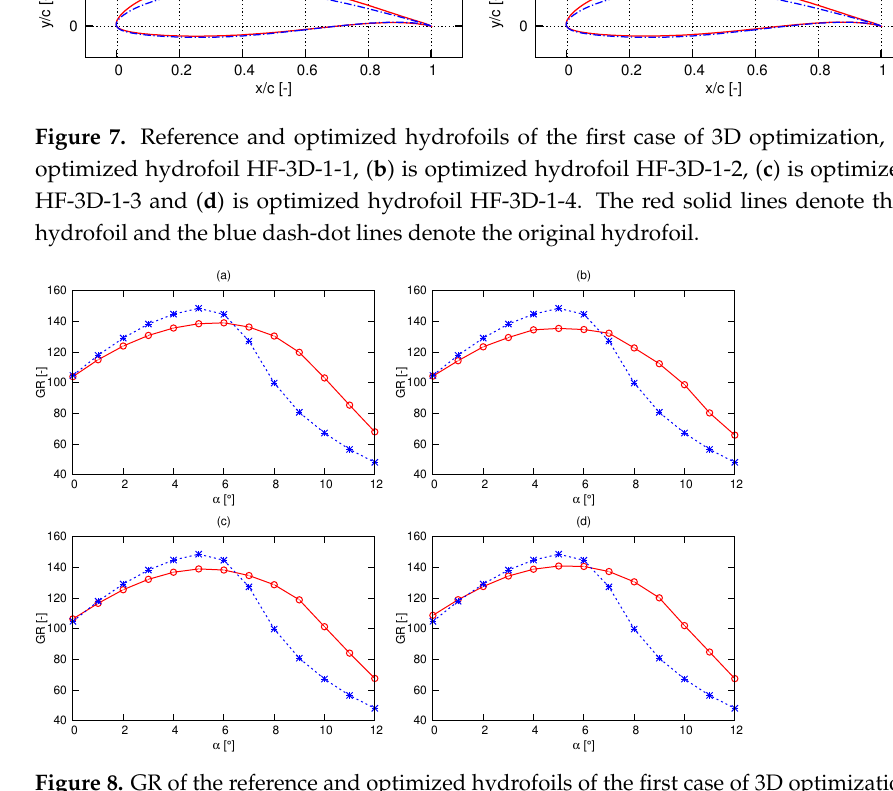
Figure 8. GR of the reference and optimized hydrofoils of the first case of 3D optimization, where ( a ) is GR of HF-3D-1-1, ( b ) is GR of HF-3D-1-2, ( c ) is GR of HF-3D-1-3 and ( d ) is GR of HF-3D-1-4. The red and blue lines denote optimized and reference hydrofoils, respectively.